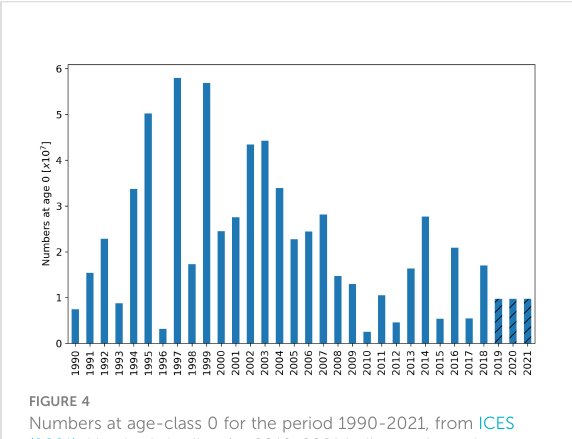
FIGURE 4 Numbers at age-class 0 for the period 1990-2021, from ICES (2021). Hatched shading for 2019-2021 indicates that values are based on mean recruitment over 2009-2018.